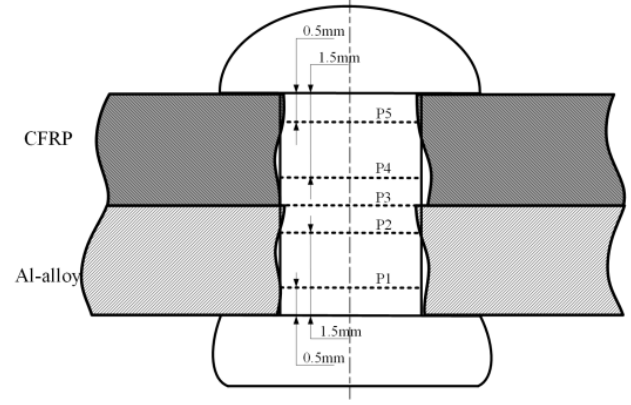
Figure 10. Measurement positions for Interference-fit size.